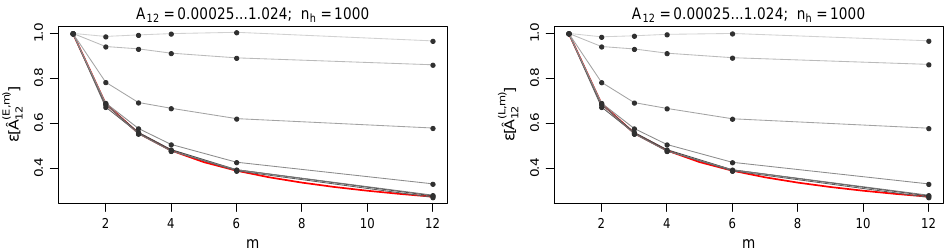
] and ε [ ˆ A ( L , m ) ] as a function of m, considering increasing i σ (from darker to brighter curve) Figure 2. ε [ ˆ A ( E , m ) 12 12 and n h = 10 3 . The red curve is the theoretical value of ε regime. For σ 1 , σ 2 (cid:28) 1 the analytical result is perfectly satisfied. However, ε decreasing function of m in general. Comparing this result with the n h = ∞ case, we can state that (cid:104) (cid:105) ˆ A ( L , m ) ε is almost insensitive to n h ( h = 1,2). hh (cid:48)